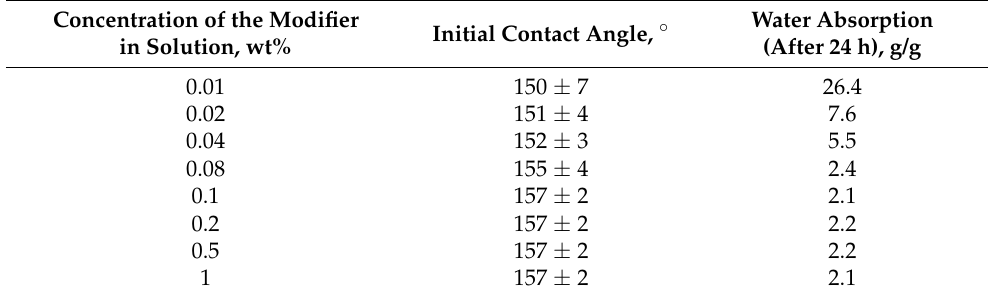
Table 6. Initial contact angle and water absorption of chitosan aerogels modified at 140 ◦ C for 1 h using poly(GMA-co-TDMA) solutions at varying concentrations.